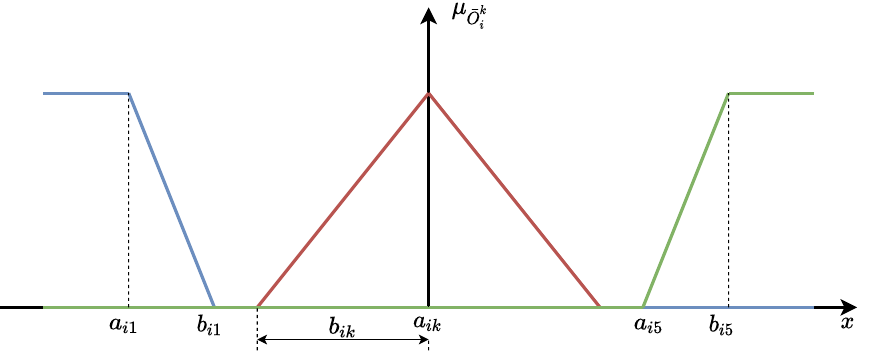
Figure 3. Topology of the fuzzy controller.